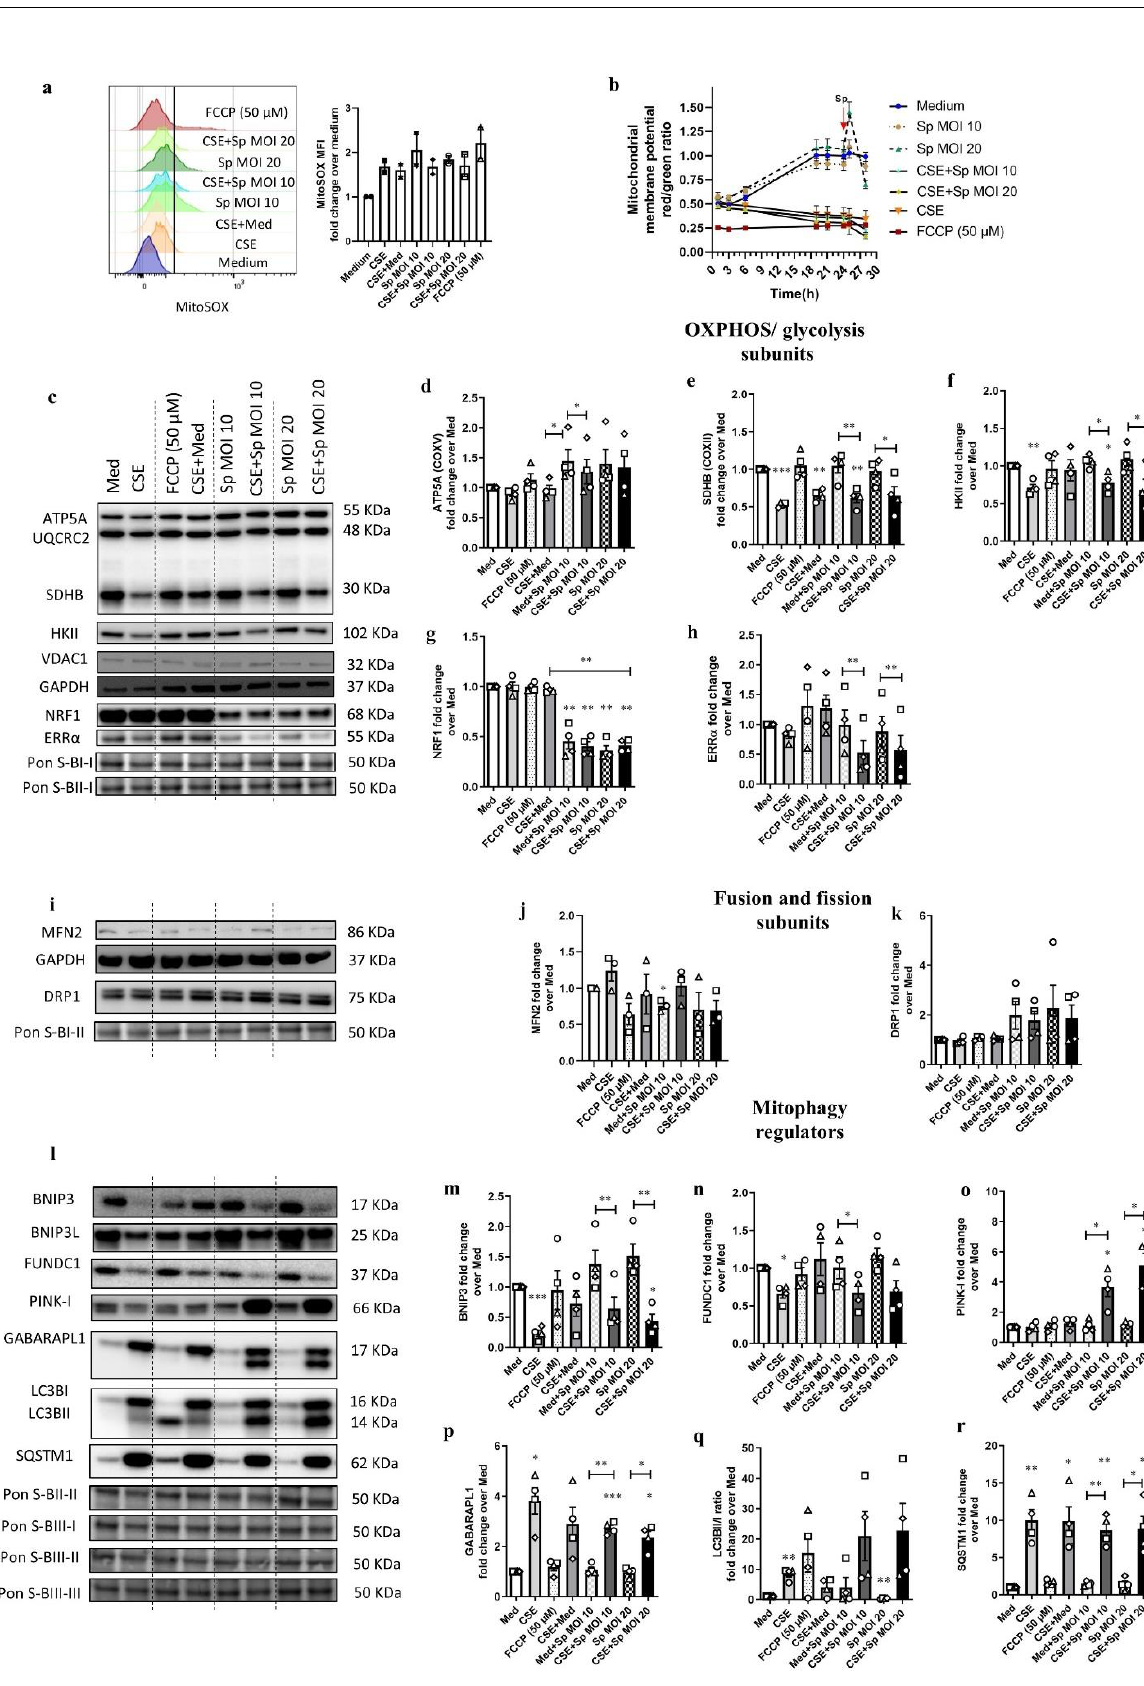
Figure 5. Cigarette smoke extract exposure followed by Streptococcus pneumoniae infection induced mitochondrial dysfunction in 16HBE cells. 16HBE cells were incubated with either medium (Med) for 28 h, cigarette smoke extract (CSE) for 28 h, CSE for 24 h followed by medium for 4 h (cessation),